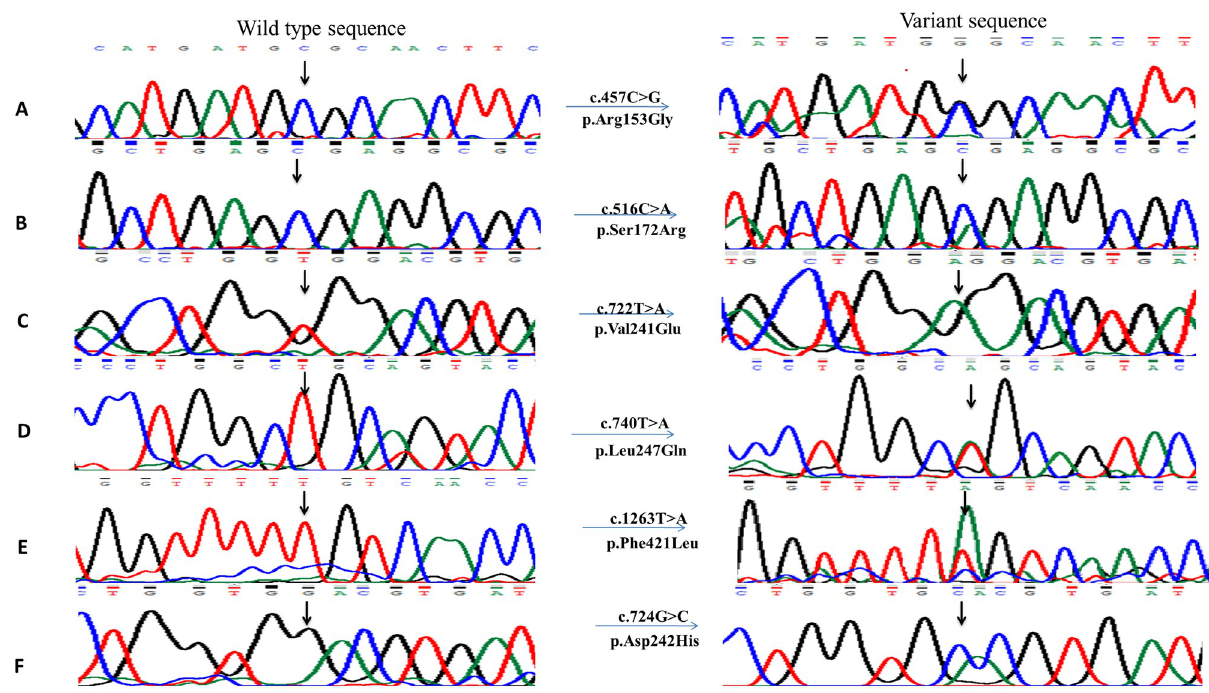
Fig 3. Chromatograms of novel disease-causing single nucleotide substitutions detected in PCG patients upon sequencing of CYP1B1 gene. Right side of figure shows substituted nucleotides in chromatograms. A) A heterozygous variant c.457C > G detected in PCG049 leading to p.Arg153Gly. B) Second heterozygous variant c.516C > A detected in PCG049 resulting in p.Ser172Arg. C) Variant c.722T > A detected in homozygous condition in PCG052 leading to protein change p.Val241Glu. D) A heterozygous variant c.740T > A leading to p.Leu247Gln detected in PCG060. E) Sequence chromatogram of heterozygous variant c.1263T > A detected in PCG062 resulting in p.Phe421Leu. F) A homozygous variant c.724G > C leading to p. Asp242His detected in PCG067.